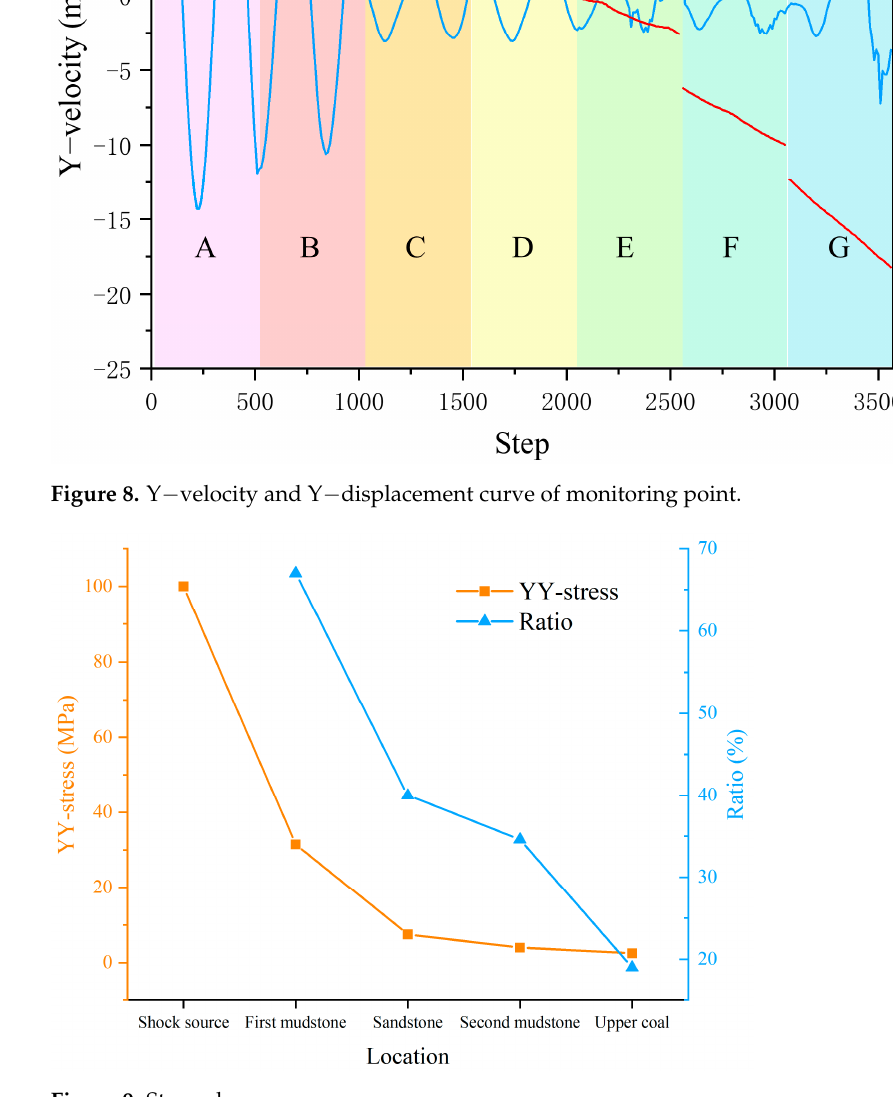
Figure 9. Stress decay curves.